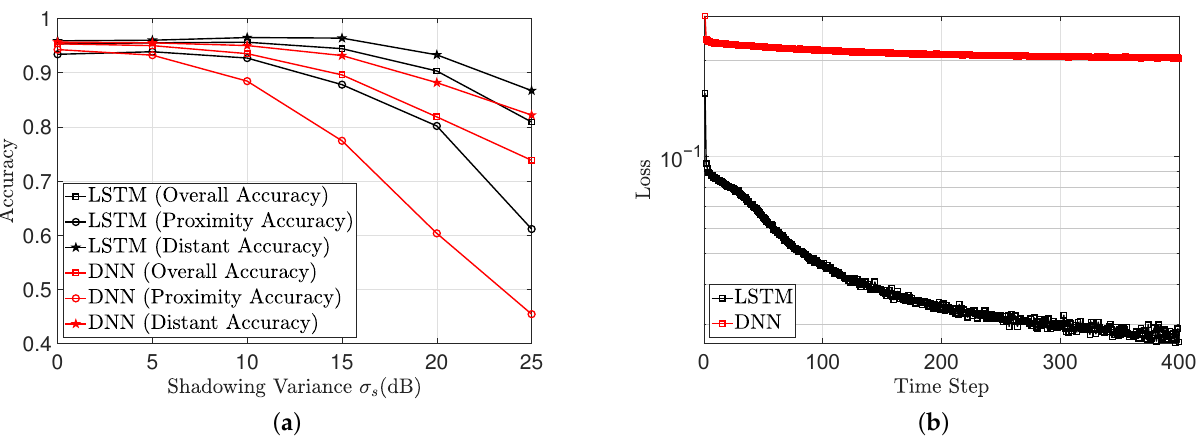
Figure 11. ( a ) Accuracy versus shadowing variance. ( b ) Training loss versus time step.